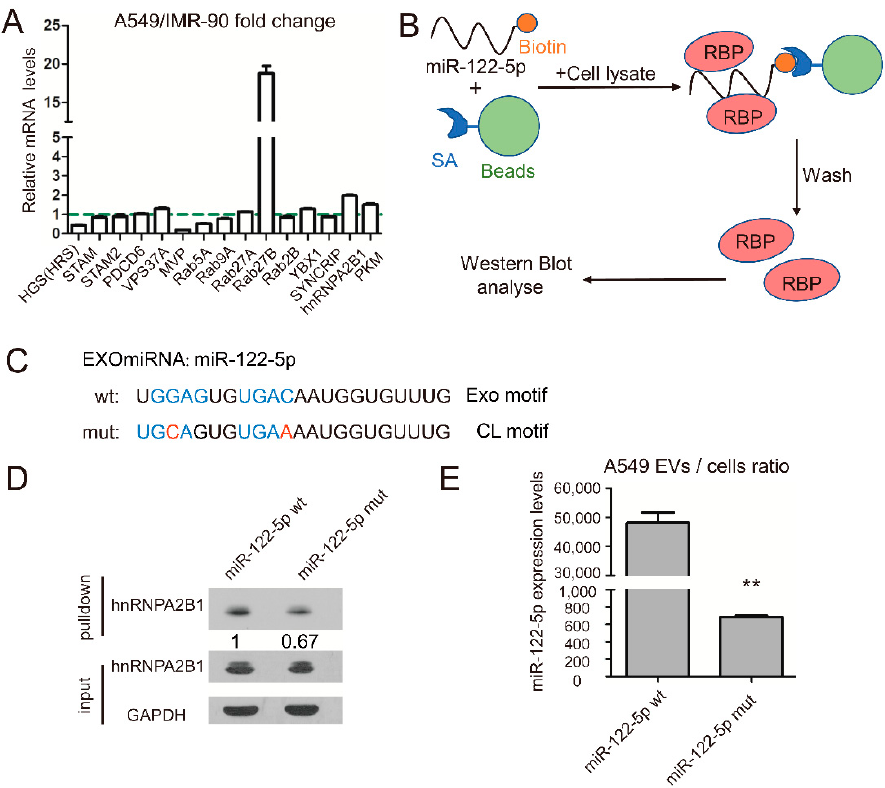
Figure 3. RNA-binding protein hnRNPA2B1 binds miR-122-5p through specific motifs. ( A ) The qPCR results show the mRNA expression levels of 15 candidate EVs sorting-related genes in A549 cells compared to IMR-90 cells. ( B ) Schematic diagram of biotin labelled miRNA-protein pulldown assay. ( C ) Sequences of wild-type miRNAs and their mutated versions used in this study. The mu- tated miR-122-5p (mut) has two CL motifs, while the wild-type miR-122-5p has two EXO motifs. ( D ) RNA pulldown assay showed that miR-122-5p bound to hnRNPA2B1, and the mutation of EXO motifs on miR-122-5p decreased its binding strength to hnRNPA2B1. ( E ) The mutations changed the ratio of miR-122-5p expression between EVs and cell lysate in A549. Three independent experi- ments were performed, and the statistical analyses were performed with the Student’s t test. **: p < 0.01.